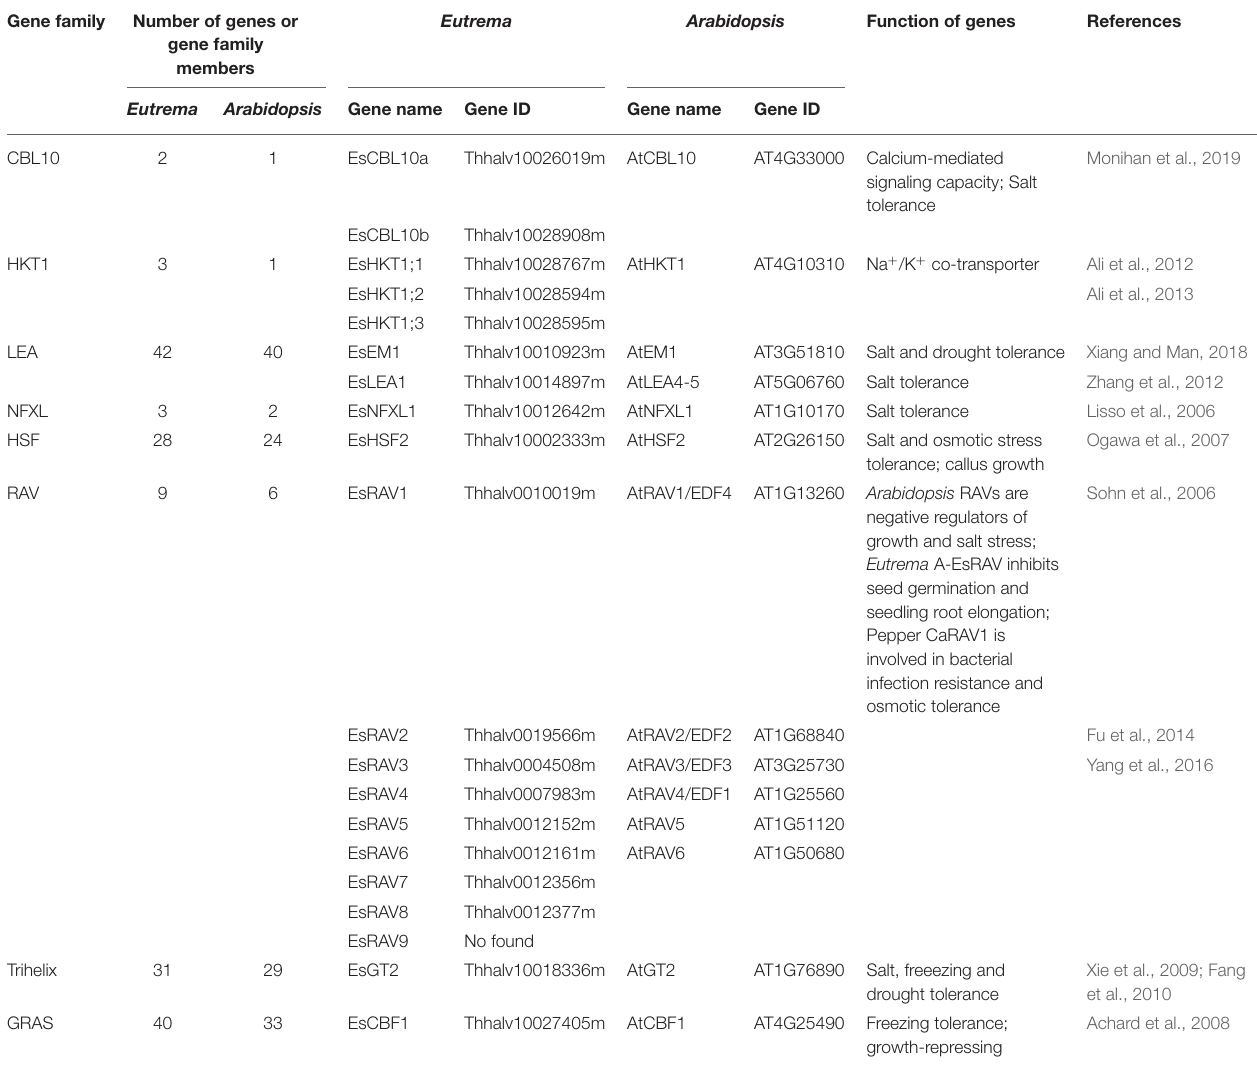
TABLE 1 | The expanded genes or gene family members involved in response to salt stress in Eutrema compared with Arabidopsis . Gene